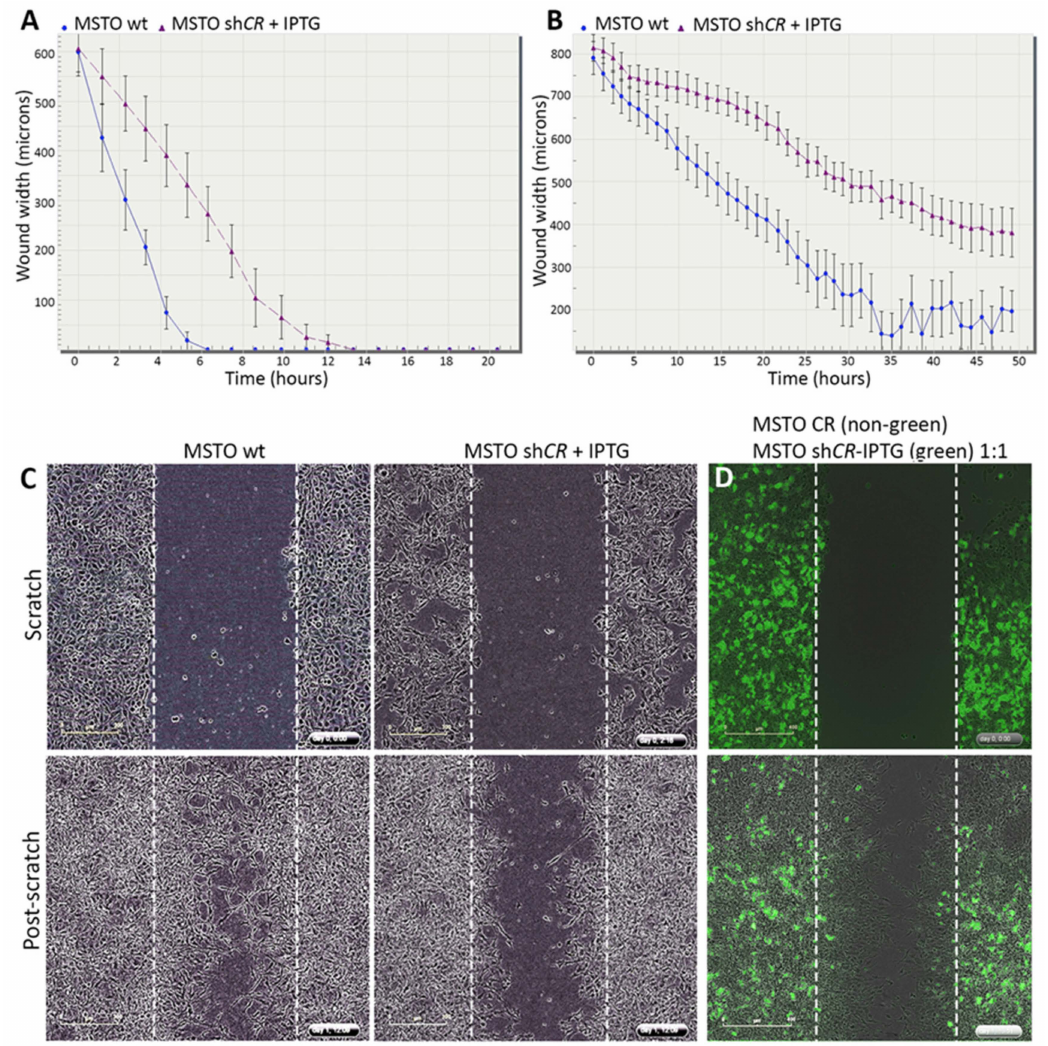
Figure 2. CR downregulation decreases migration and invasion of MSTO-211H cells. ( A ) Comparison of scratch closure kinetics (migration) between MSTO-wt ( blue ) and MSTO-shCALB2-IPTG (induced) cells ( purple ) monitored with the IncuCyte ™ imaging system every 2 h. ( B ) Invasiveness was